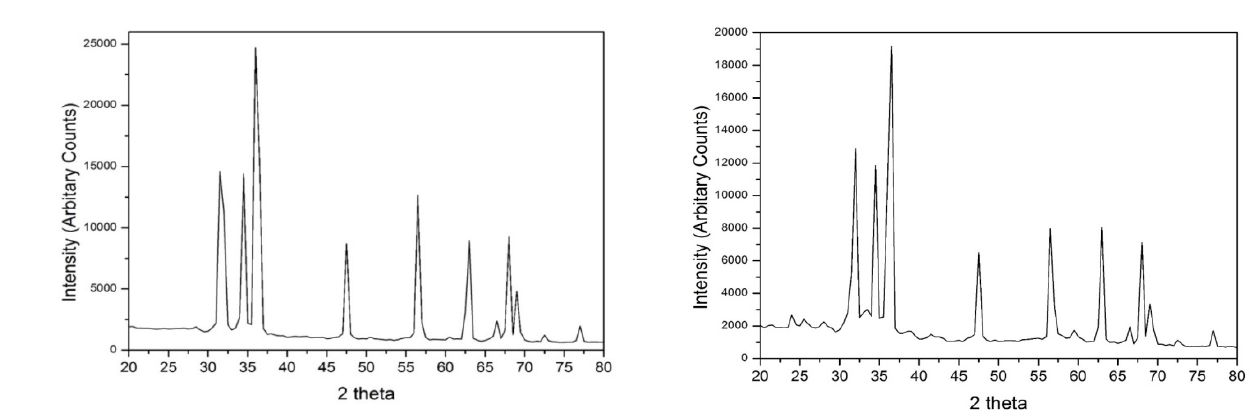
Figure 1: PXRD of Nano-ZnO particles. Figure 2: PXRD of Bulk -ZnO particles.